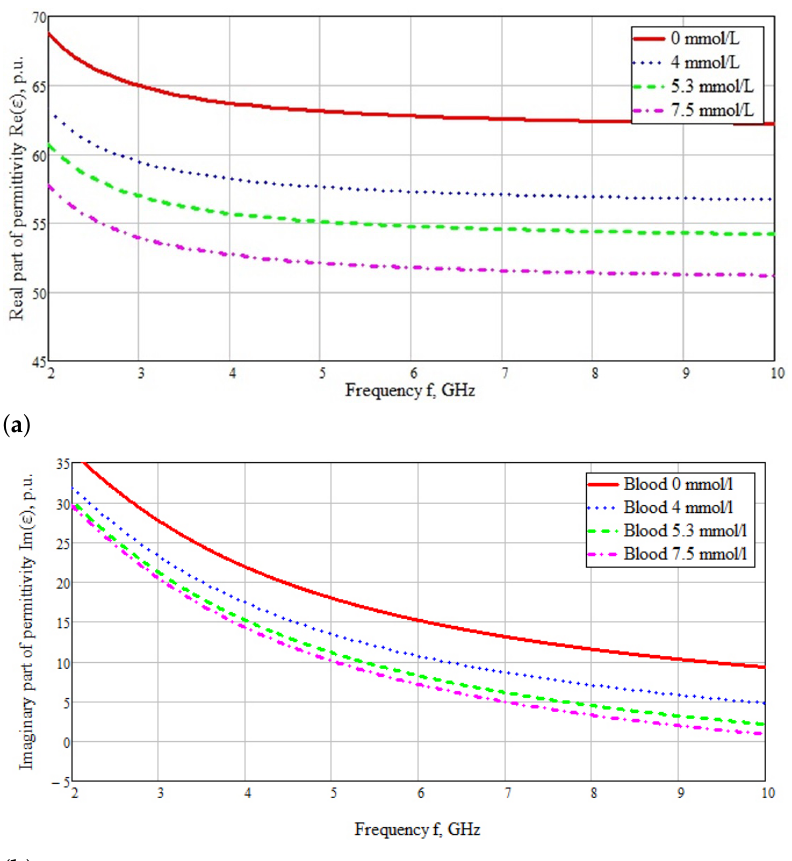
Figure 11. Frequency dependence of the real ( a ) and imaginary ( b ) parts of the relative permittivity of biological tissues such as